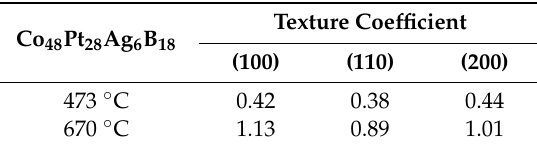
Table 2. The texture coefficients calculated for L1 0 superlattice peaks for samples annealed at 473 ◦ C and 670 ◦ C.